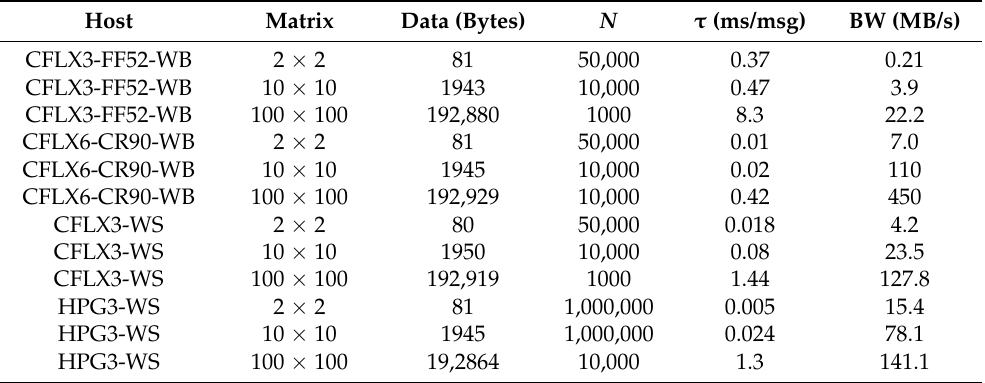
Table 2. Communication latency τ and bandwidth BW for local-worker communication using channels by sending serialized matrix data (initialized with random numbers) between a worker and the main